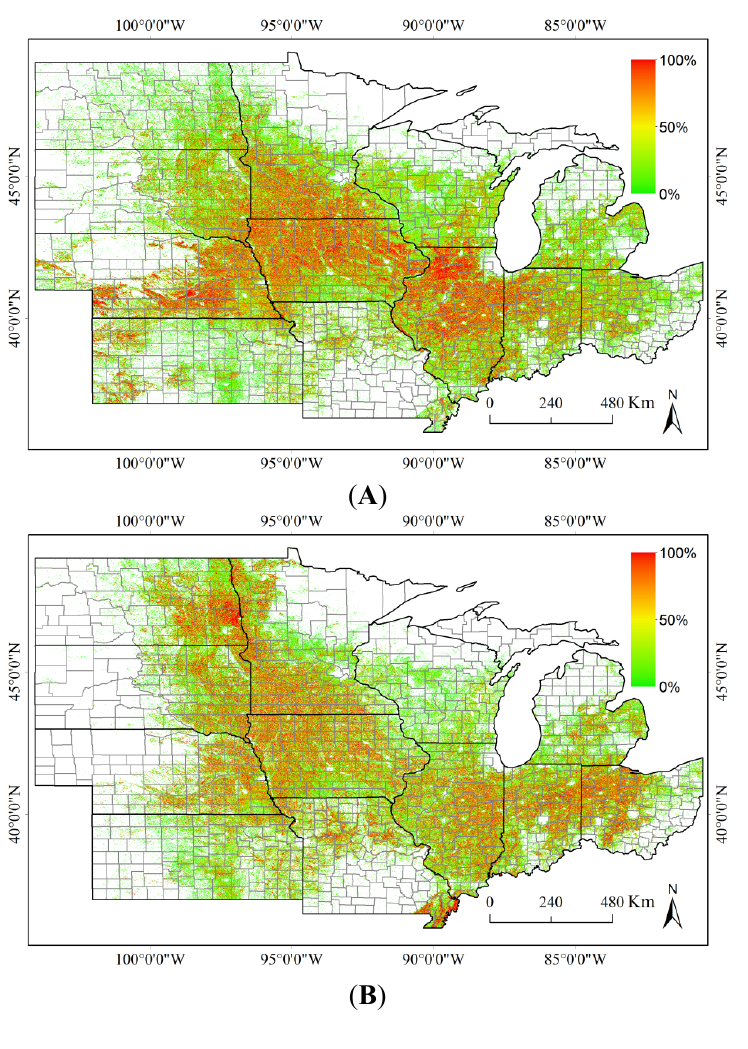
Figure 2. The percentage maps of corn and soybean in 2011 from the NASS CDL program.